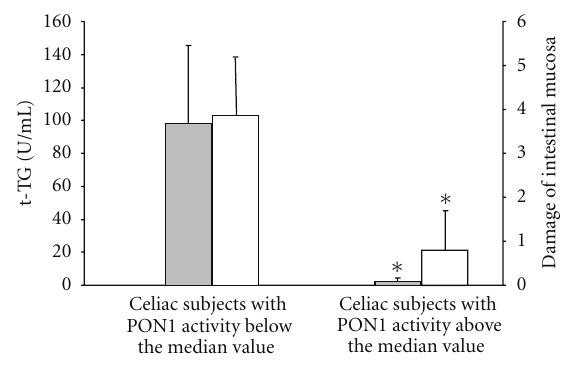
Figure 1: Mean levels of antitransglutaminase(t-TG) antibodies levels (grey square) and degree of damage of intestinal mucosa classified according to Marsh parameters (white square) in celiac patients with PON1 activity above or below the median value (124.6U/mL). ∗ P < 0 . 001 versus celiac patients with PON1 activity below median